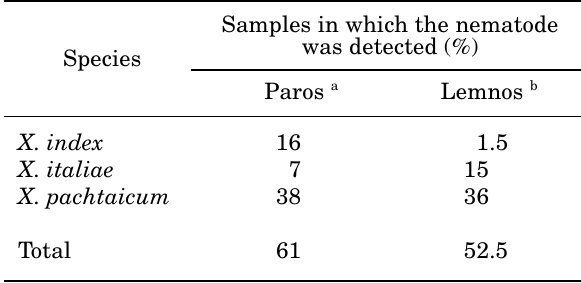
Table 3. Occurrence of Xiphinema species in soil sam- ples from the islands of Paros and